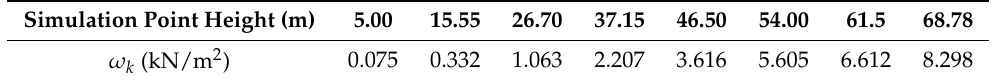
Table 7. Tower wind-load loading basic parameters.